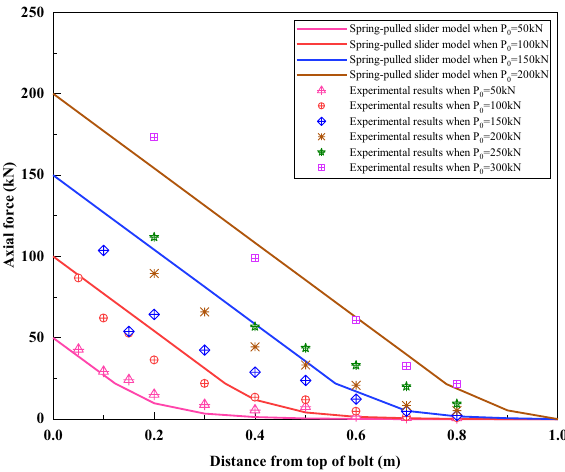
Figure 20. Comparison between the spring-pulled slider model and the test results.